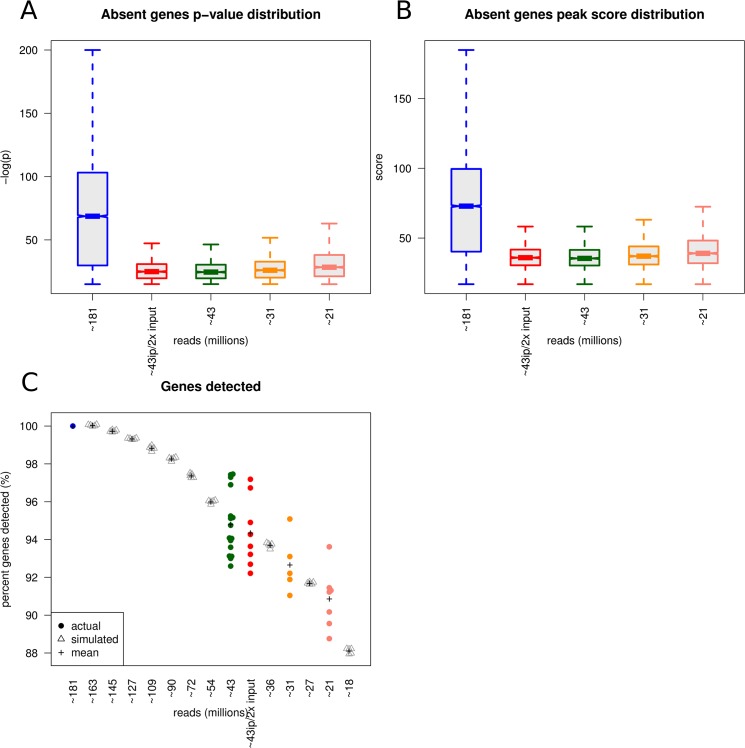
Characteristics of peaks lost due to reduced coverage and gene anntations of peaks from simulated reduced coverage.A) P-value distributions of peaks from gene annotations absent from multiplexed libraries showing the genes lost due to multiplexing having less significant peak p-values and appearing in the lower quartile of the 1-plex distribution. B) Peak width distributions of genes absent from multiplexed libraries showing that genes lost due to multiplexing having shorter peak widths and appearing in the lower quartile of the 1-plex distribution. C) Multiplexing was simulated by downsampling the non-multiplexed sample data in 10% increments from 90% to 10% in 5 replicates. There is strong agreement among the experimental and simulated data showing a gradual decrease in the number of gene annotated peaks as multiplexing increases and multiplexing to ~18M reads (currently 10% of a lane) can recover 88% of gene annotated peaks.